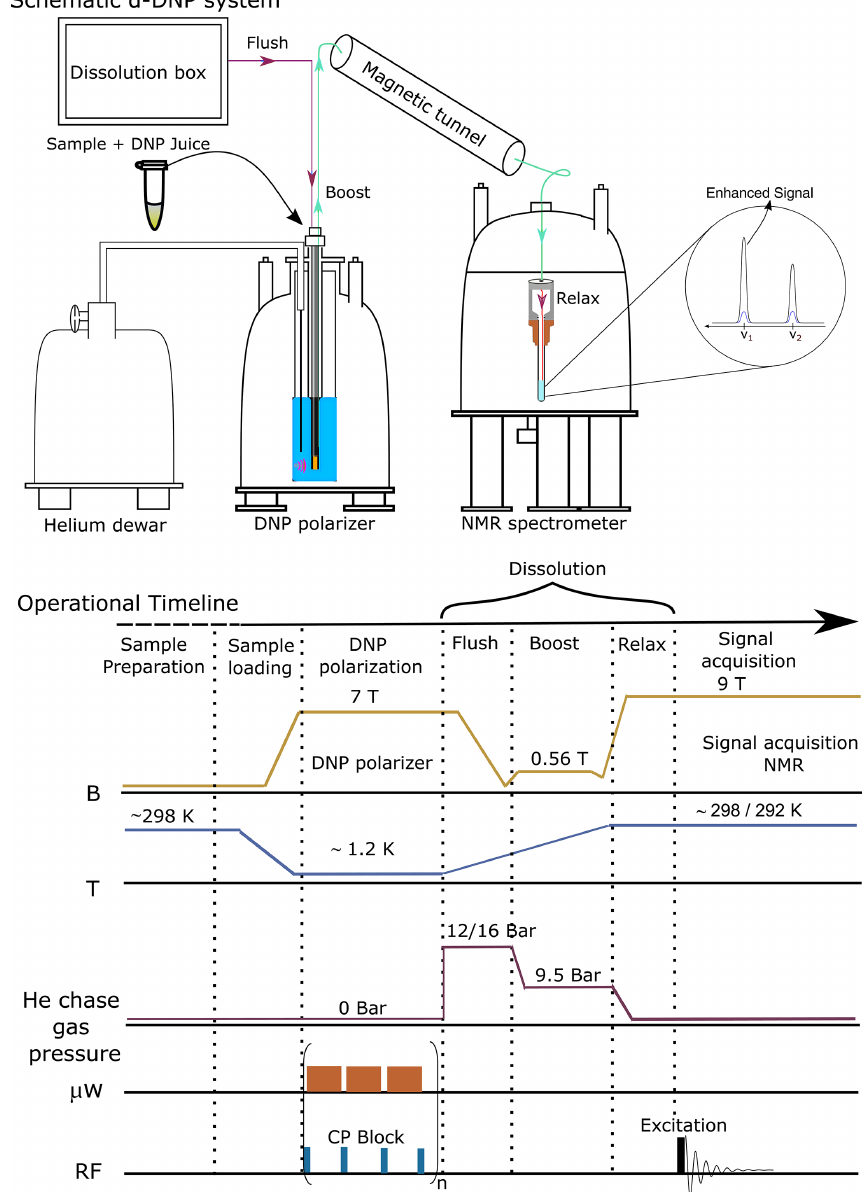
Figure 1. Schematic description of the semi-automated prototype dissolution DNP system along with operational timeline, indicating im- portant events during d-DNP operation in